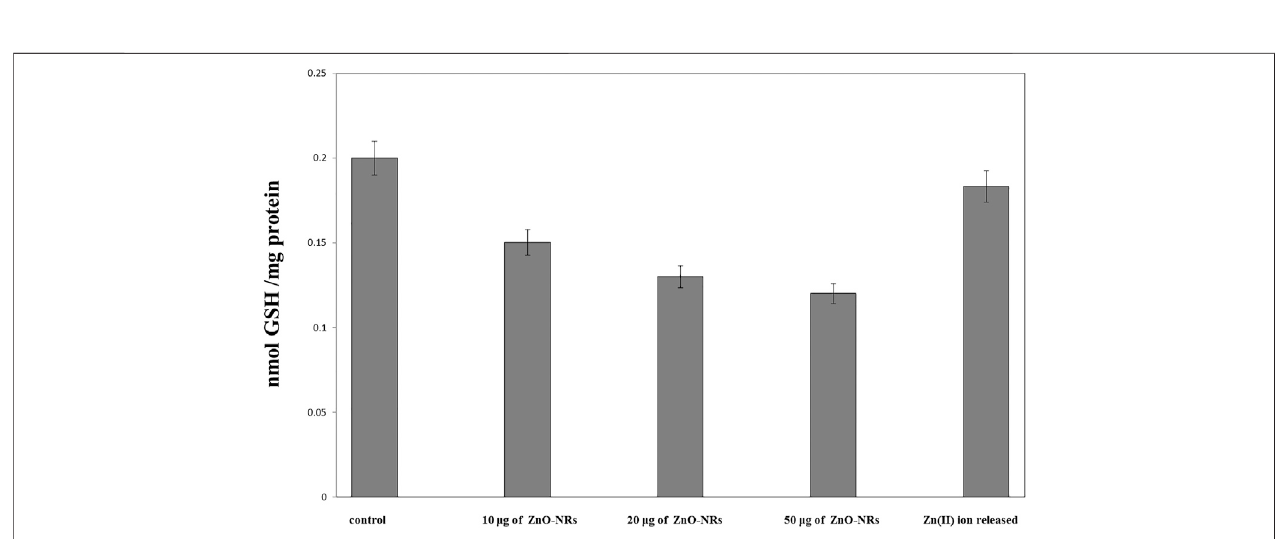
FIGURE 8 | Glutathione peroxidase enzyme of ZnO nanorods (ZnO-NRs) and released zinc (II) ions from ZnO nanorods (ZnO-NRs).